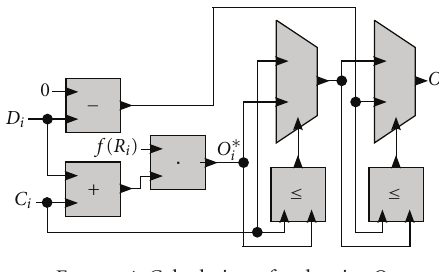
Figure 4: Calculation of order size O i .